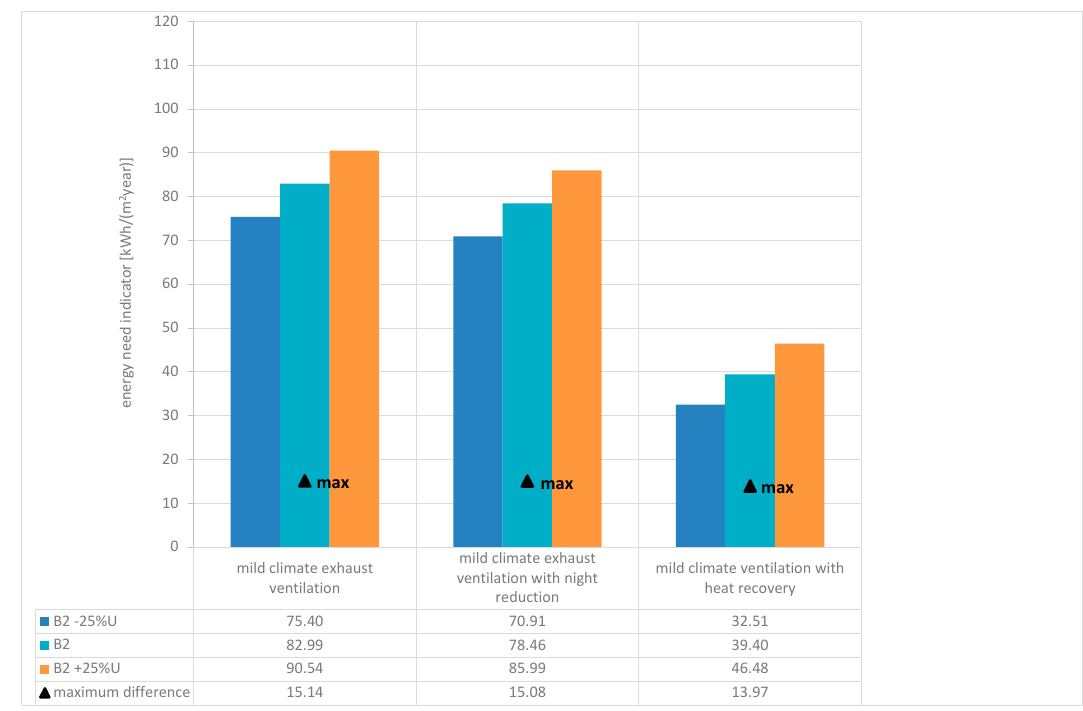
Figure 4. The impact of the building envelope thermal transmittance on the energy need indicator.